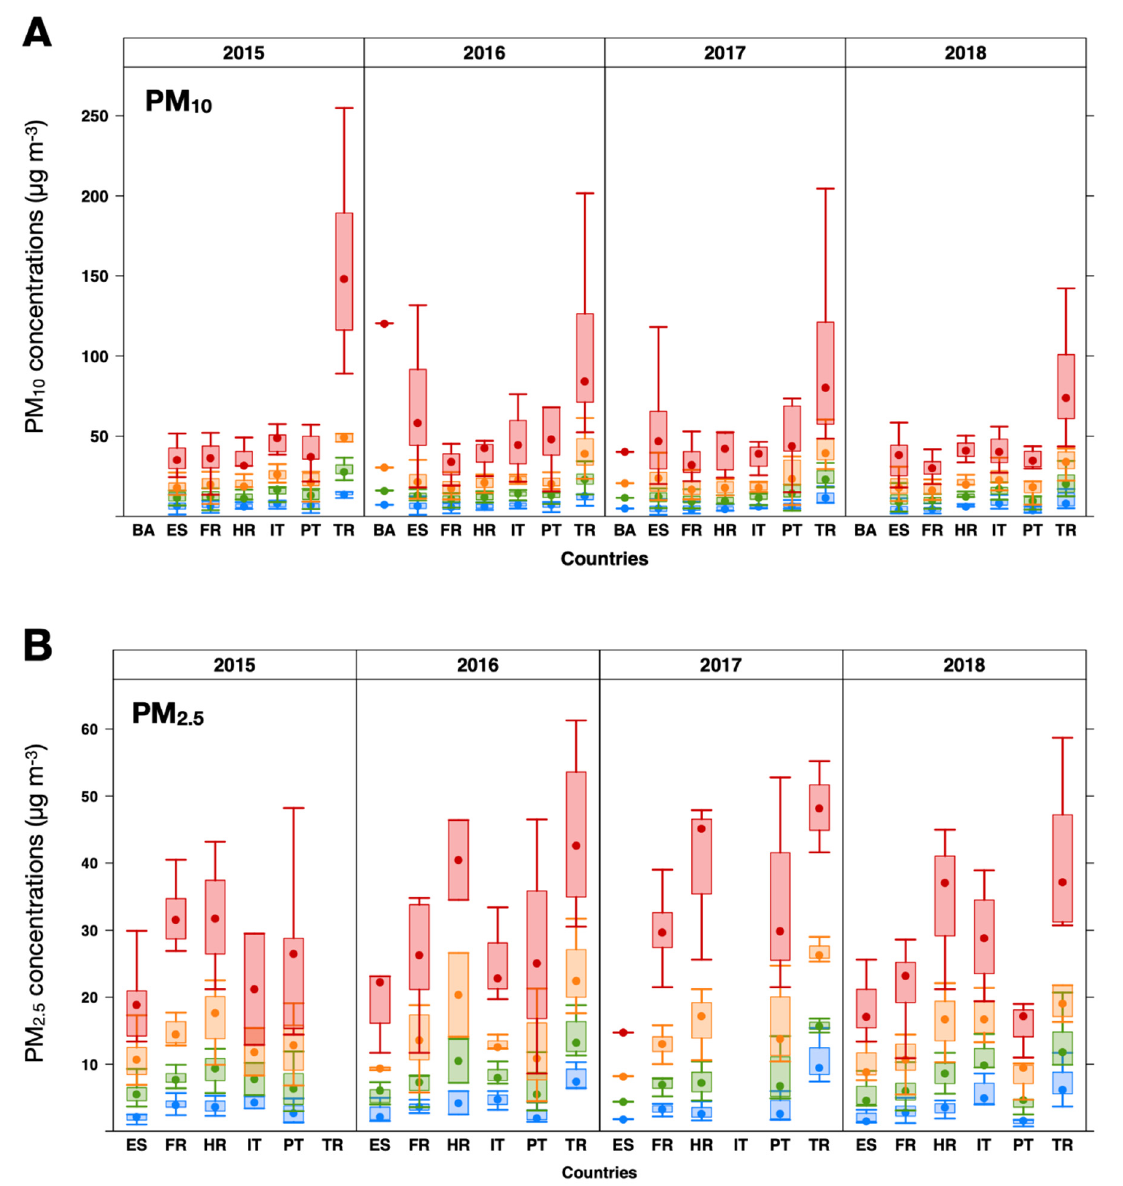
Figure 4. PM 10 ( A ) and PM 2.5 ( B ) pollution profiles from monitoring sites by countries (2015–2018). First to fourth pollution profiles are shown in blue, green, orange, and red, respectively. ES—Spain; FR—France; HR—Croatia; IT—Italy; PT—Portugal; TR—Turkey.